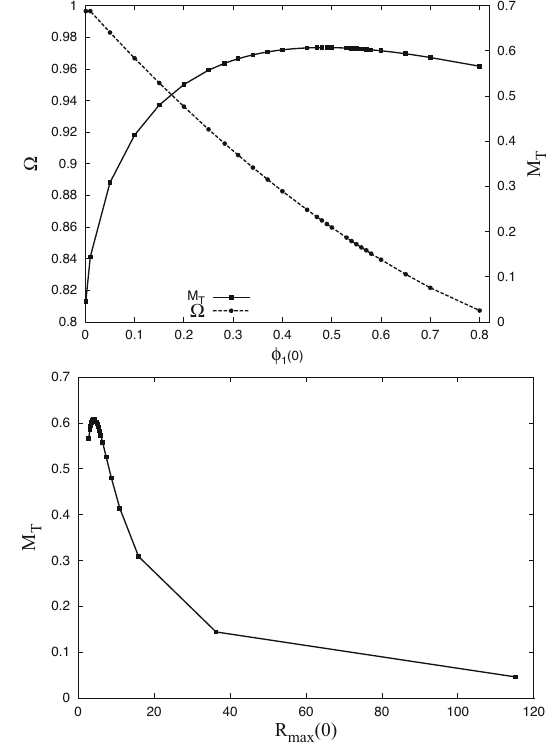
Fig. 6 Top : Total mass (in units = m ) and fundamental of M 2 Planck frequency of an oscillaton as a function of the central value of the scalar fi eld / 1 ð r ¼ 0 Þ . The maximum mass is = m . M max ¼ 0 : 607 M 2 Planck Bottom : Plot of the total mass versus the radius at which g rr achieves its maximum. Reproduced with permission from Alcubierre et al. (2003); copyright by